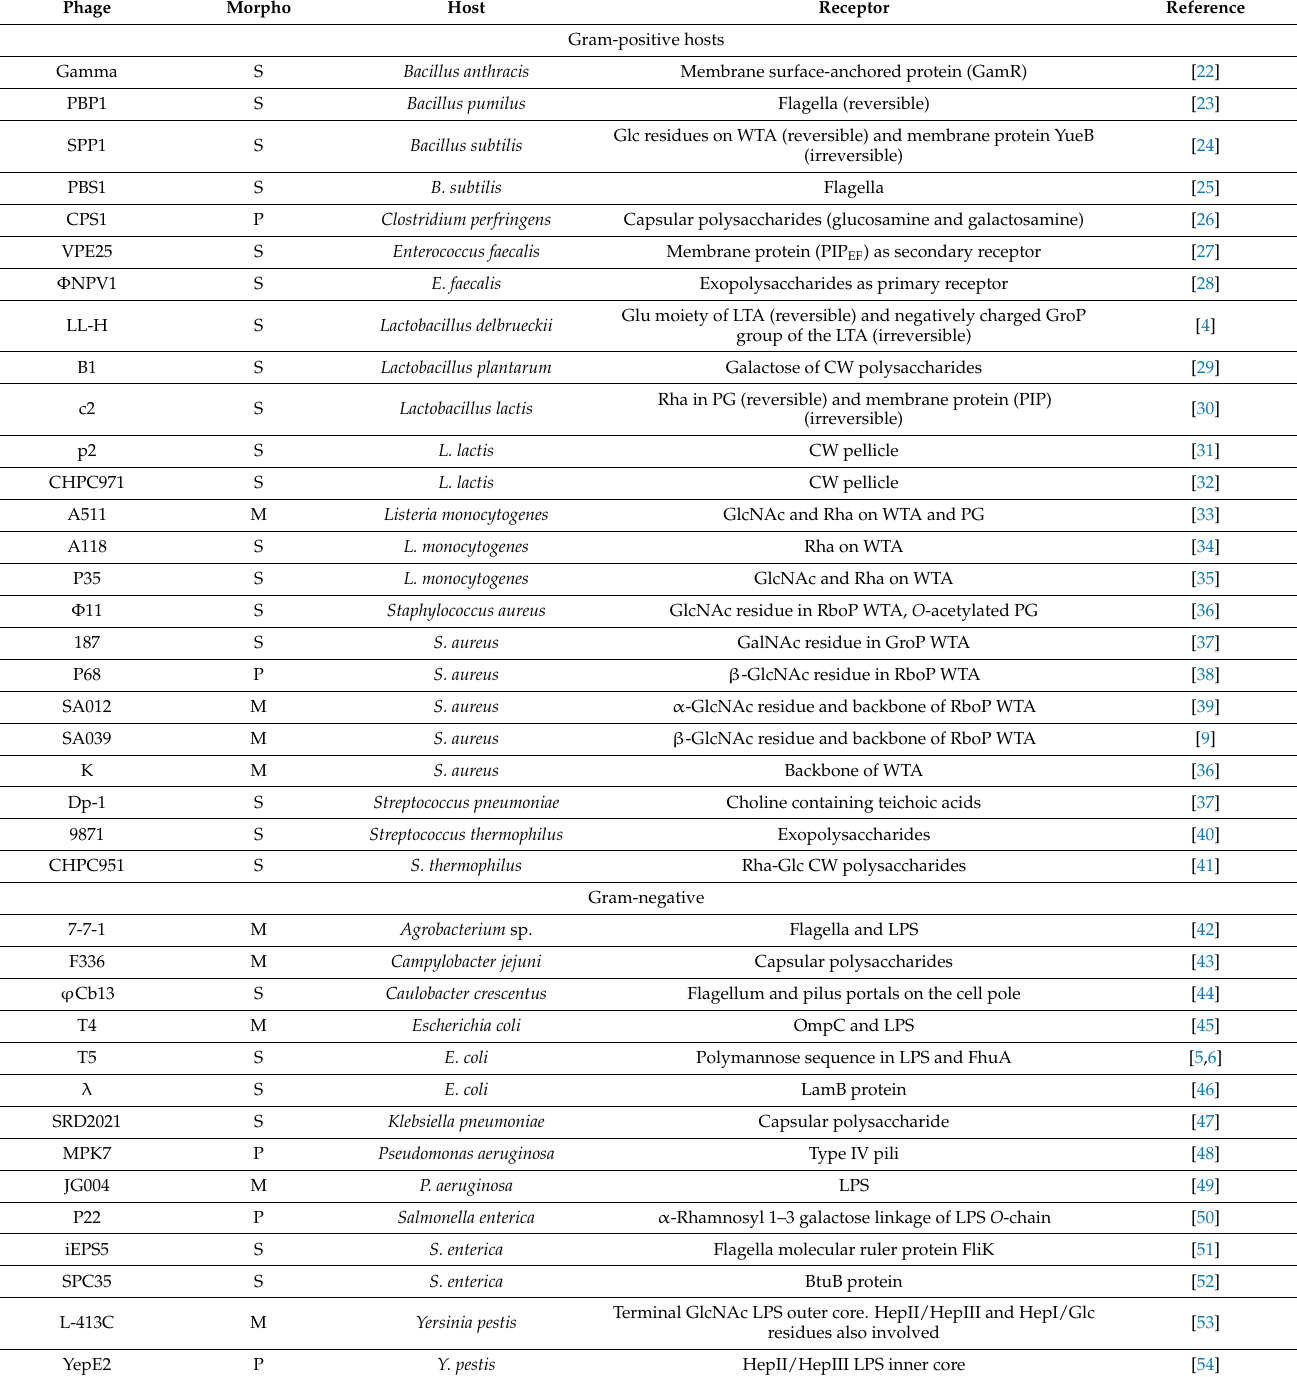
Table 1. Example of receptors recognized by phages infecting Gram-positive and Gram-negative bacteria. The phage morphology is indicated: myovirus (M), siphovirus (S), or podovirus (P). WTA: wall teichoic acid, LTA: lipoteichoic acid, CW: cell wall, PG: peptidoglycan, LPS: lipopolysaccharide, Rha: rhamnose, Glu: glucose, GlcNac: N -acetyl-glucosamine, GalNac: N -acetyl-galactosamine, RboP: polyribitol phosphate, GroP: polyglycerol phosphate, Hep: heptulose.